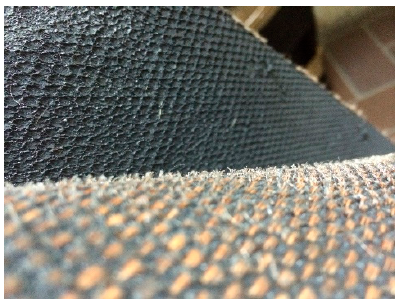
Figure 13. Roughened ply in the splice on belt type EP 1800/5.